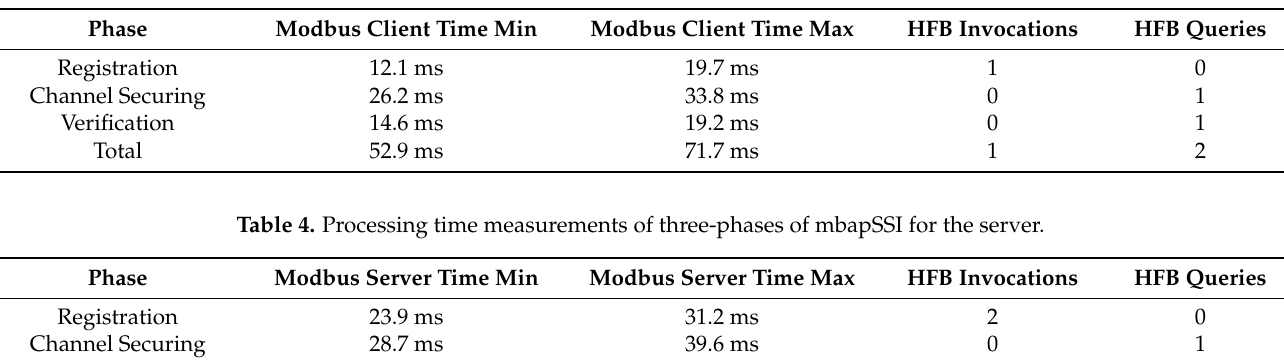
Table 3. Processing time measurements of three-phases of mbapSSI for the client.